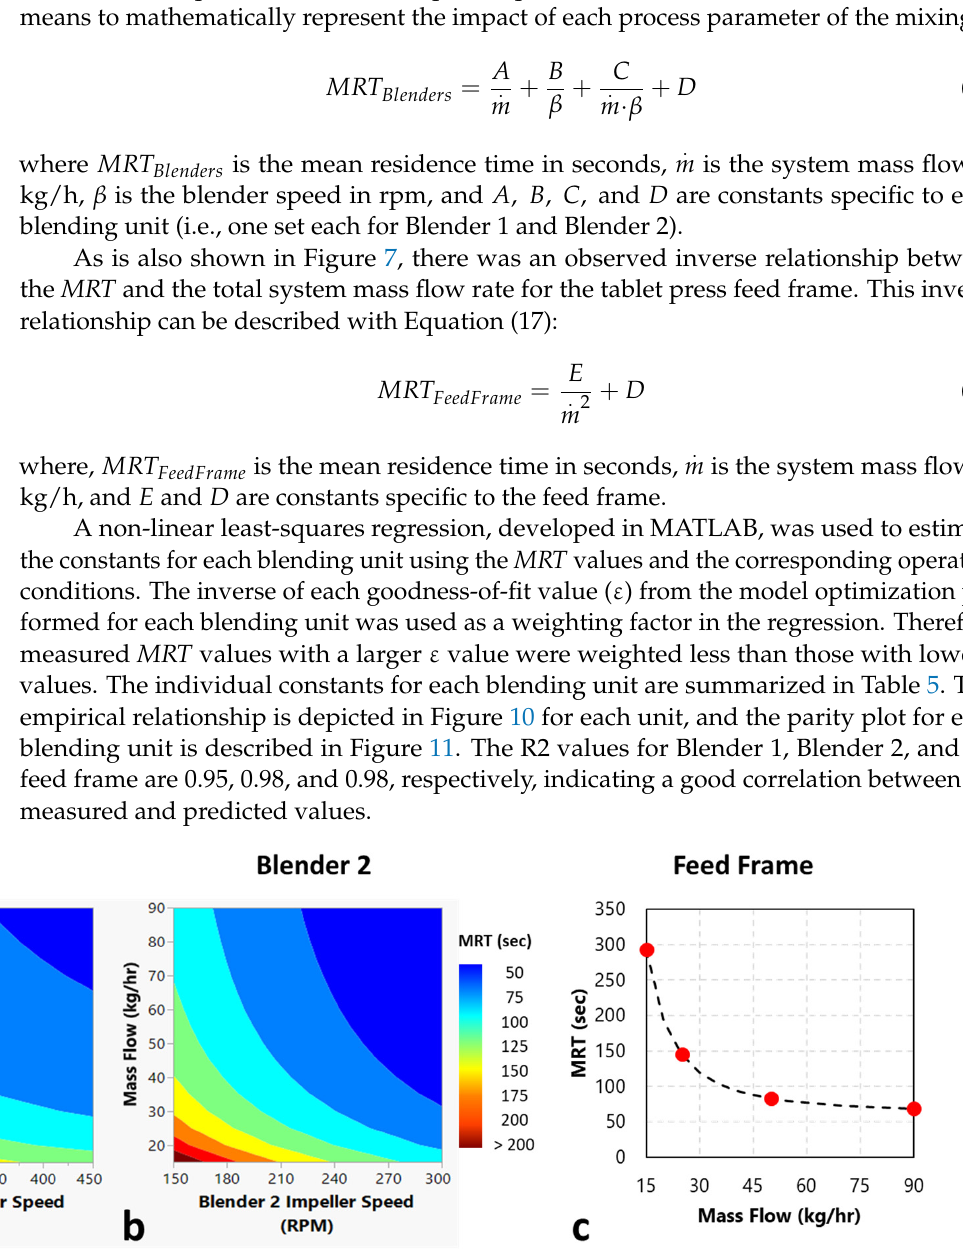
Figure 10. Plots describing the developed empirical relationship for each unit. ( a ) Contour plot for Blender 1 MRT versus mass flow rate and Blender 1 impeller speed. ( b ) Contour plot for Blender 2 MRT versus mass flow rate and Blender 2 impeller speed. ( c ) Plot for feed frame MRT versus mass flow rate.